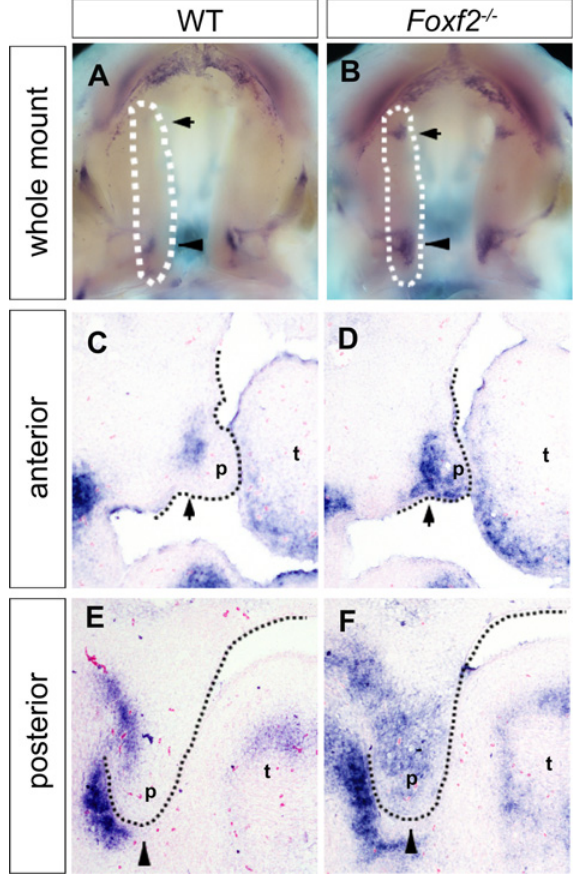
Fig 5. Comparison of expression of Fgf18 mRNAs in the palatal shelves in wildtype and Foxf2 -/- mutant embryos. (A, B) Whole-mount in situ hybridization detection of Fgf18 mRNAs in the developing palatal shelves in wildtype (A) and Foxf2 -/- mutant (B) embryos at E13.5. White dashes demarcate the palatal shelf on the right side. Note that Fgf18 is ectopically expressed in specific anterior (arrow) and posterior (arrow head) subdomains of Foxf2 -/- mutant palatal shelves. (C-F) Frontal sections showing expression of Fgf18 mRNAs in the anterior (C, D) and posterior (E, F) regions of the developing palatal shelves in wildtype (C, E) and Foxf2 -/- mutant (D, F) embryos at E13.5. p, palatal shelf; t,